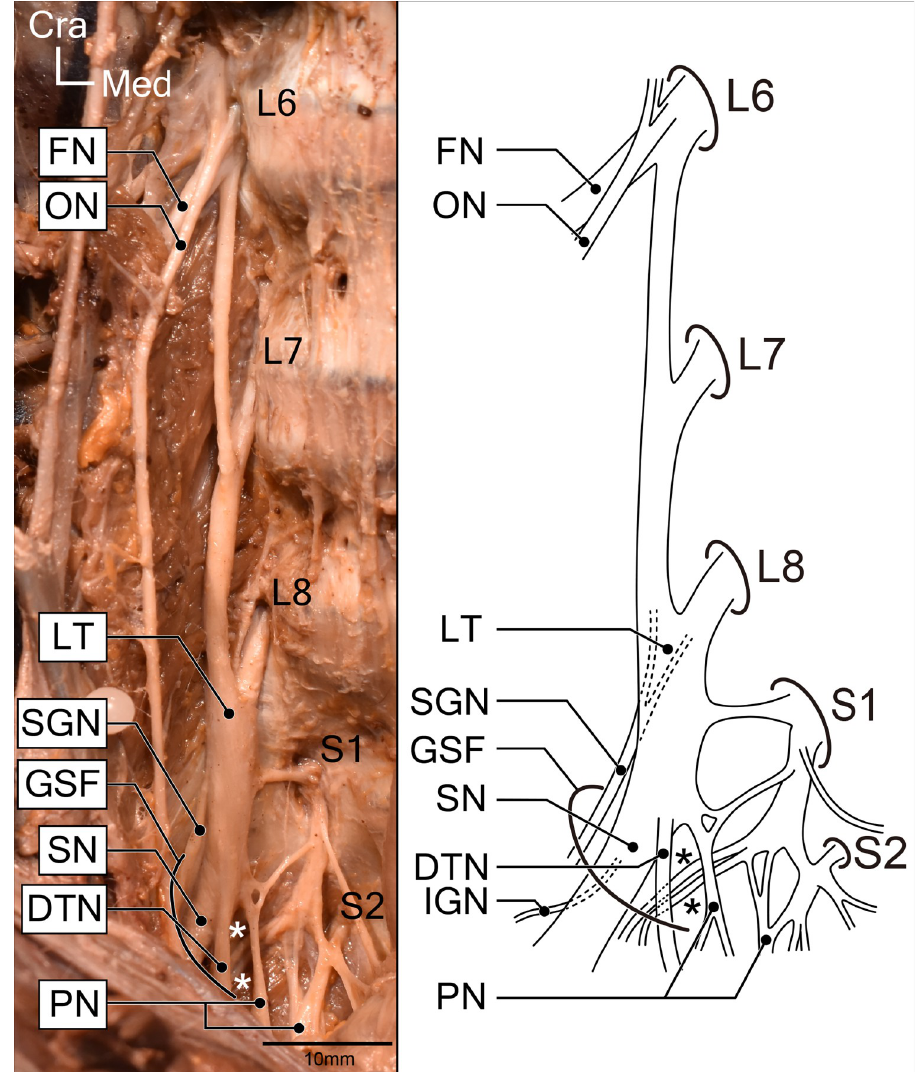
Fig 4. Right lumbosacral plexus in koalas. Photograph and illustrated corresponding schematic drawing. White and black asterisks indicate branches forming the posterior femoral cutaneous nerve and the innervating branch to the piriformis and ischiofemoralis after leaving the greater sciatic foramen. Abbreviations: DTN, deep tibial nerve; FN, femoral nerve; GSF, greater sciatic foramen; IGN, inferior gluteal nerve; LT, lumbosacral trunk; ON, obturator nerve; PN, pudendal nerve; SGN, superior gluteal nerve; SN, sciatic nerve.